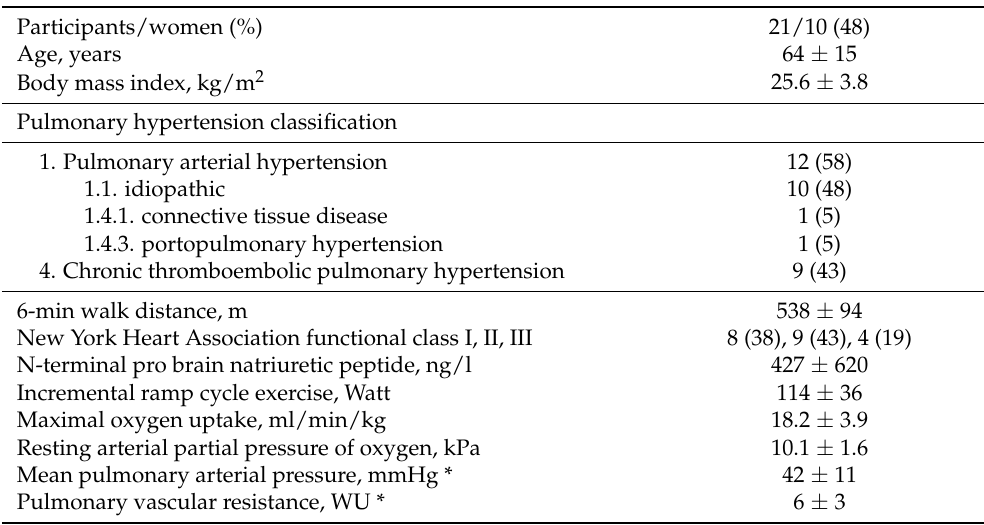
Figure 1. Flow chart: HAST = High altitude simulation test. Table 1. Baseline characteristics.